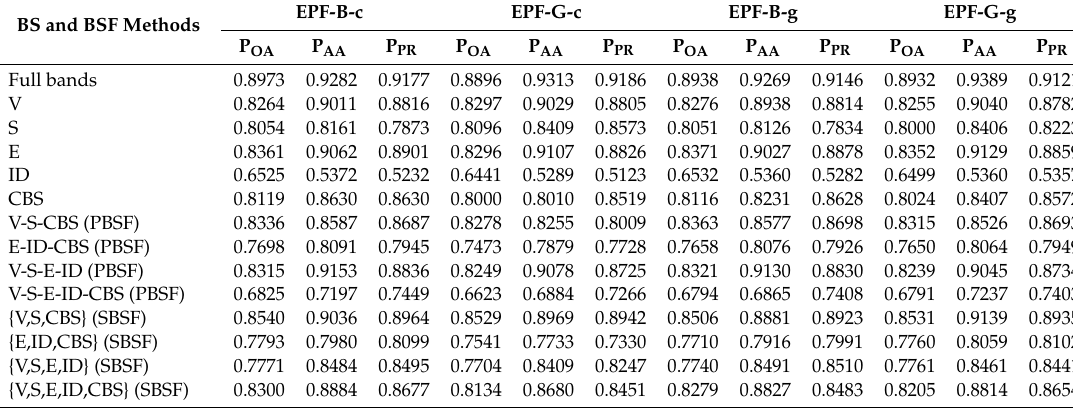
Table 8. P OA , P AA , P PR for Purdue’s Indian Pines produced by EPF-B-c, EPF-G-c, EPF-B-g and EPF-G-g using full bands and bands selected in Table